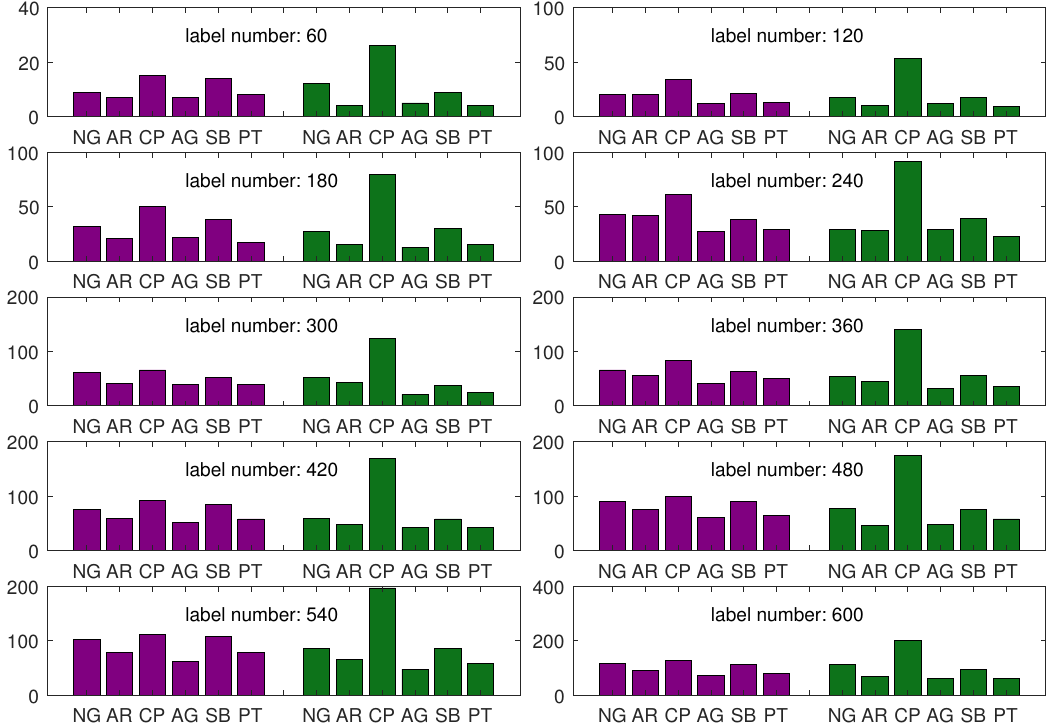
Figure 10. Distribution over classes of labelled samples generated by LS2. Green bars stand for time domain and purple for frequency domain. Y axis represents the number of the sample.